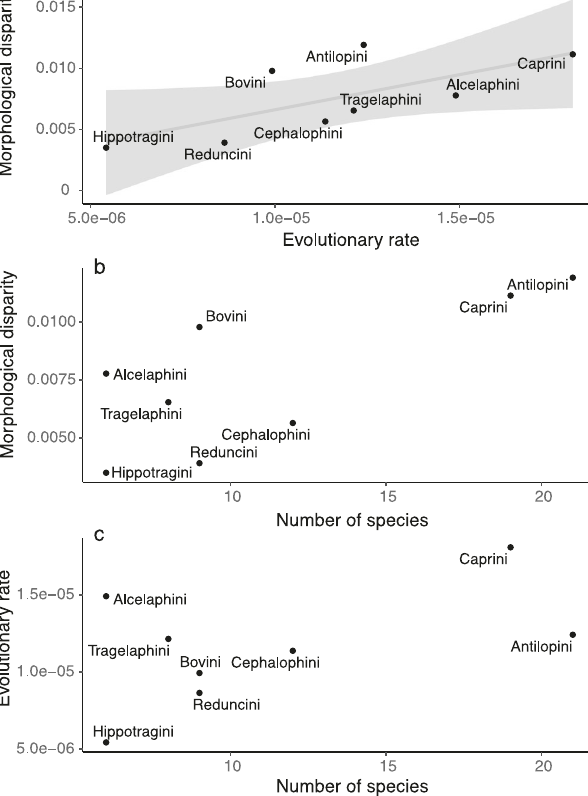
comparisons of NPP bins.